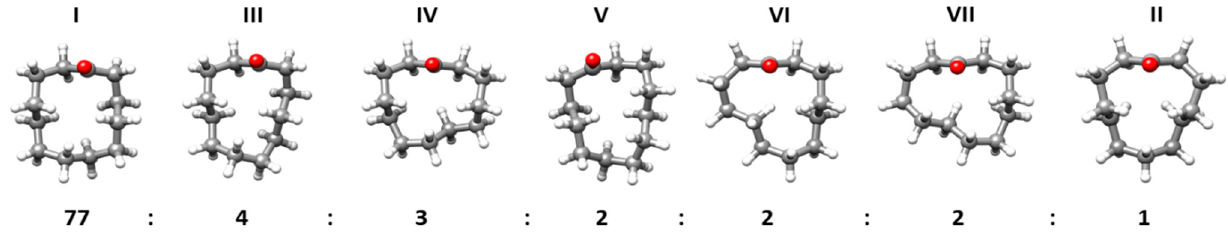
Figure 1. Relative conformational abundances of the seven observed conformers of cyclododecanone.